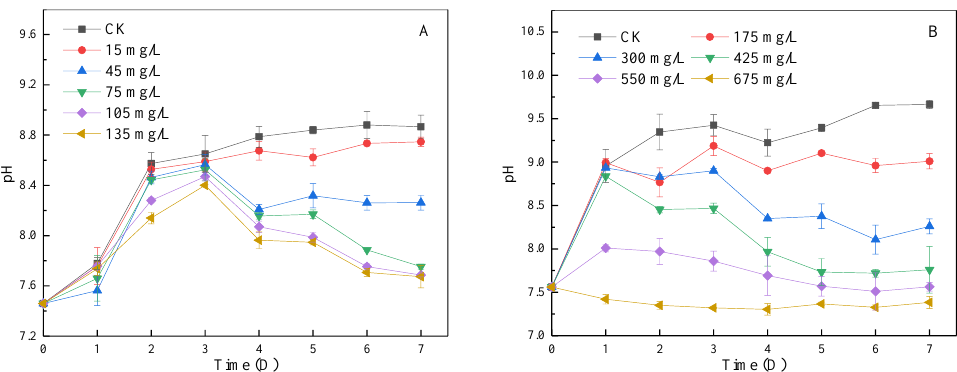
Figure 5. The effect of SA-CS on the concentration of pH in algal liquid at lag phase and log phase: ( A ) the effect of SA-CS on pH at lag phase; ( B ) the effect of SA-CS on pH at log phase.